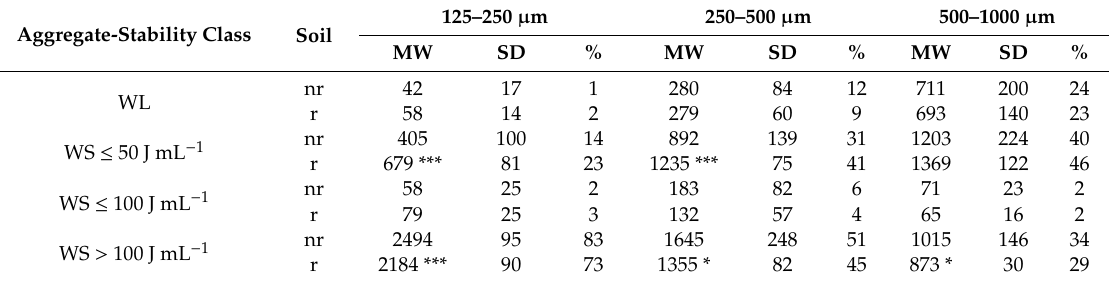
Table 2. Mean concentration (mg) and proportion (%) of aggregate-stability classes in sieve-size fractions from 125 to 1000 µ m in no-replant soil (nr) and replant soil (r) in August. Aggregate-Stability Class